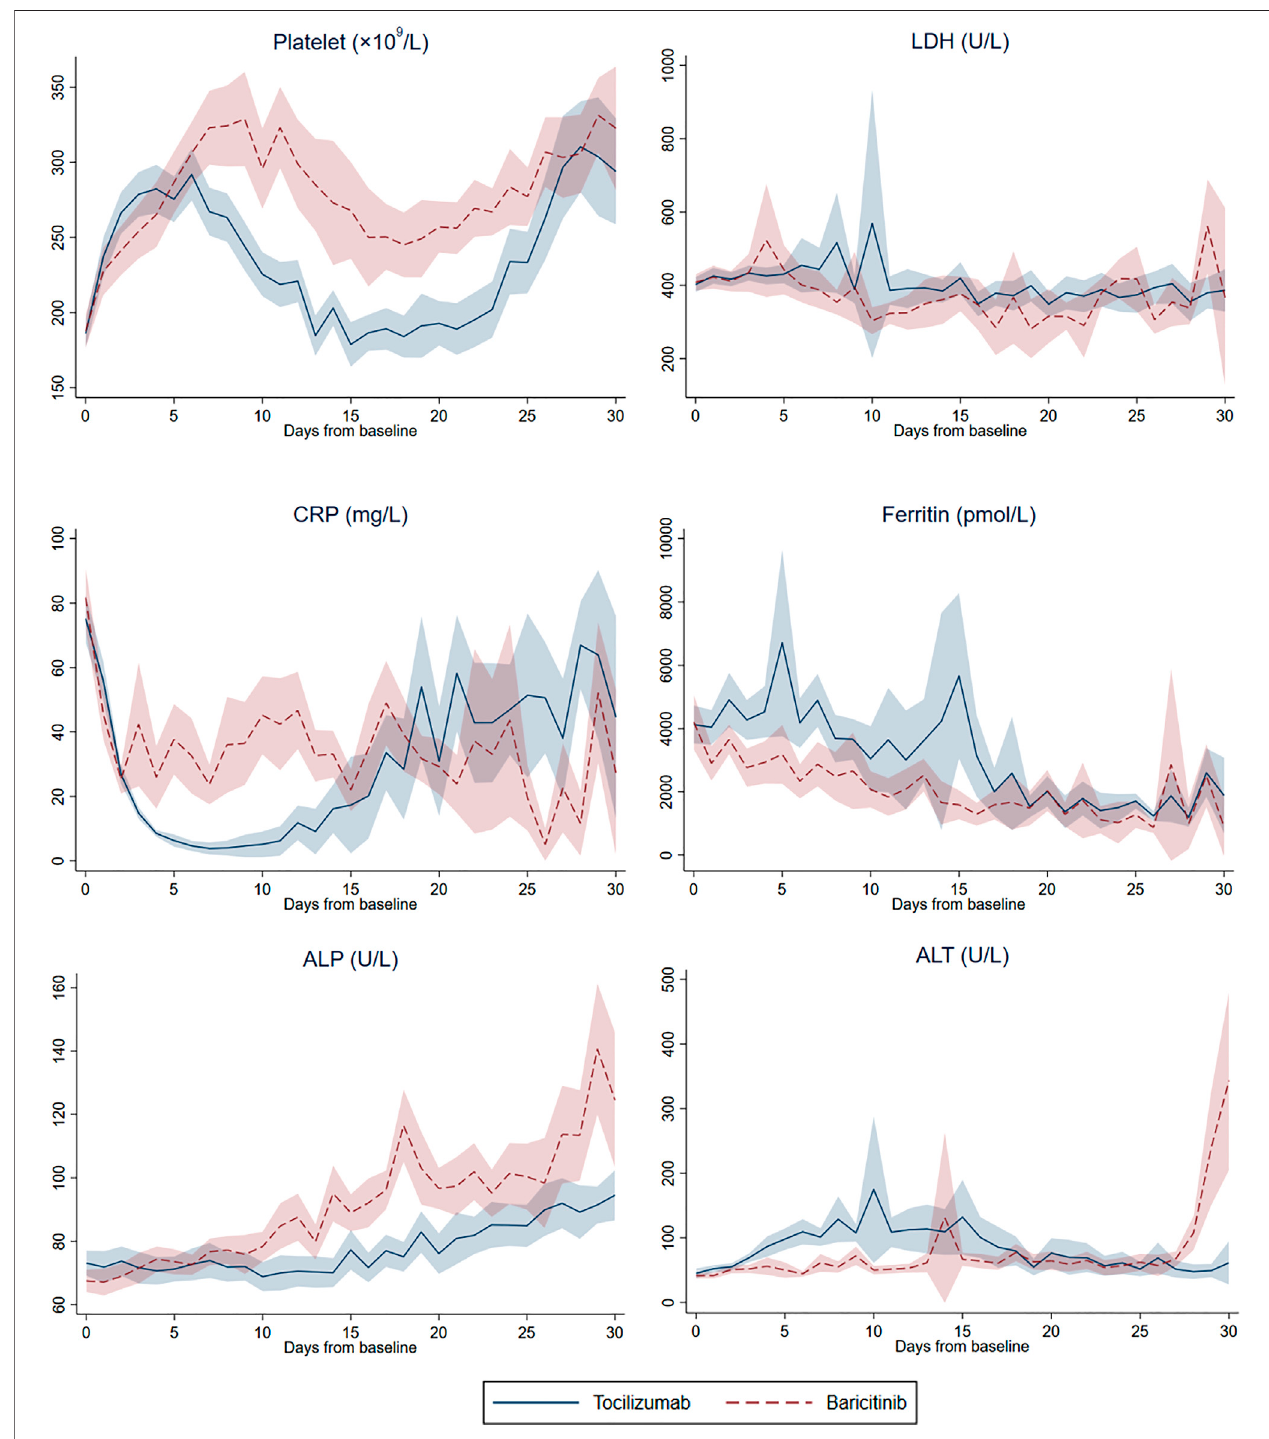
FIGURE 2 | Daily mean (and 95% con fi dence interval) platelet count, lactate dehydrogenase (LDH), C-reactive protein (CRP), ferritin, alkaline phosphatase (ALP), and alanine aminotransferase (ALT) from baseline to day-30 of follow-up in tocilizumab and baricitinib groups.